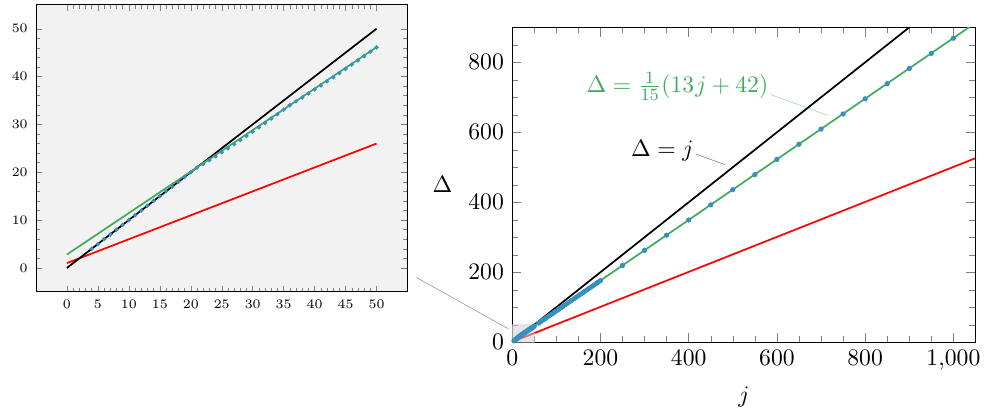
Figure 5 . Lower bounds on the conformal dimension (cid:1) as a result of the ANEC for primaries transforming in the ( 1 j; 0) Lorentz representation. Each point is the result of a bisection in (cid:1). The 2 red line is the unitarity bound, (cid:1) = 1 j + 1. The black line corresponds to the conjecture of [10], 2 (cid:1) = j , and the green line gives an approximate behavior of the bound valid above j =